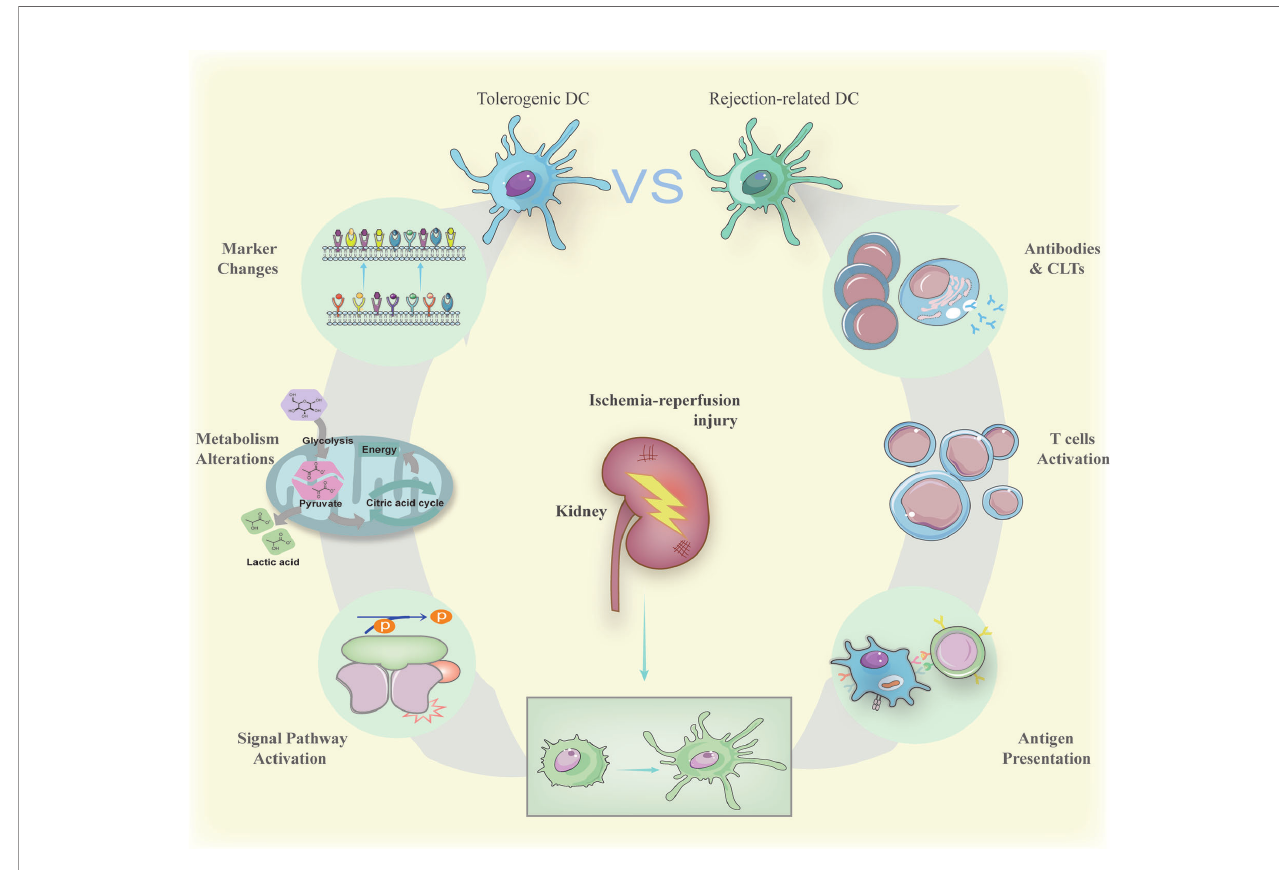
FIGURE 2 | Immature DCs can be activated by antigens derived from ischemia-reperfusion and act as the role of powerful antigen-presenting cells to trigger antibody-mediated rejection and cell-mediated rejection. The result of antibody-mediated rejection is activated B cell releasing harmful antibodies while